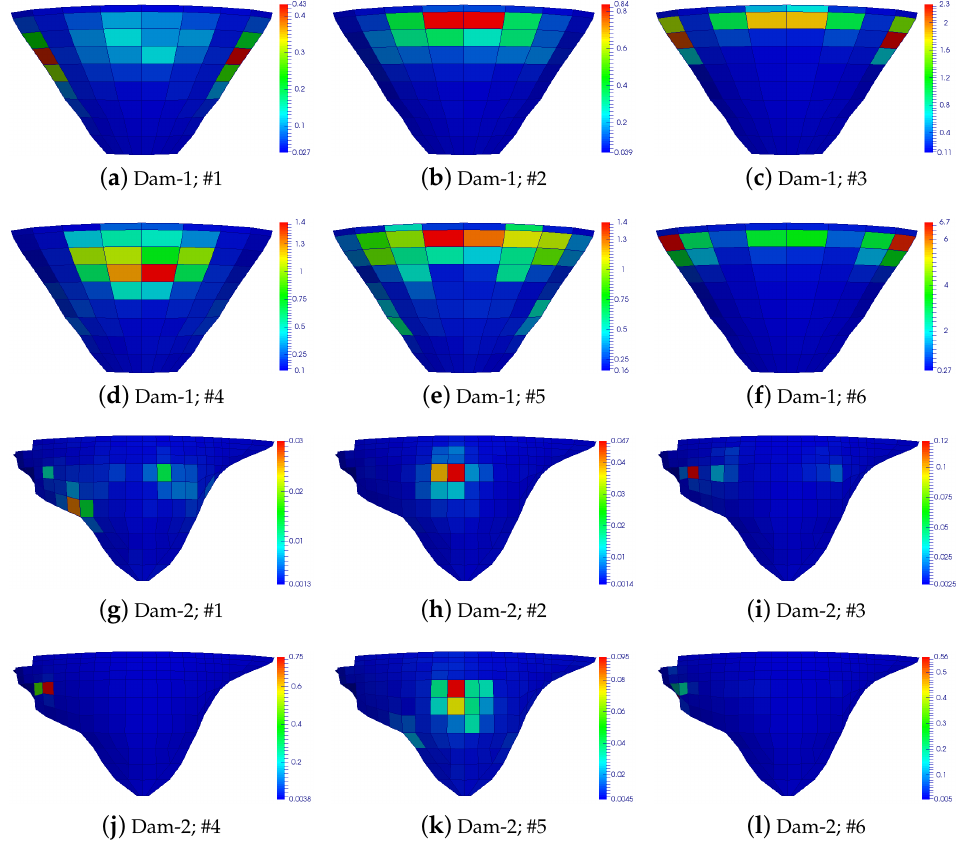
Figure 16. Random forest-based spatial distribution of sensitive location for different vibration modes in Dam-1 and